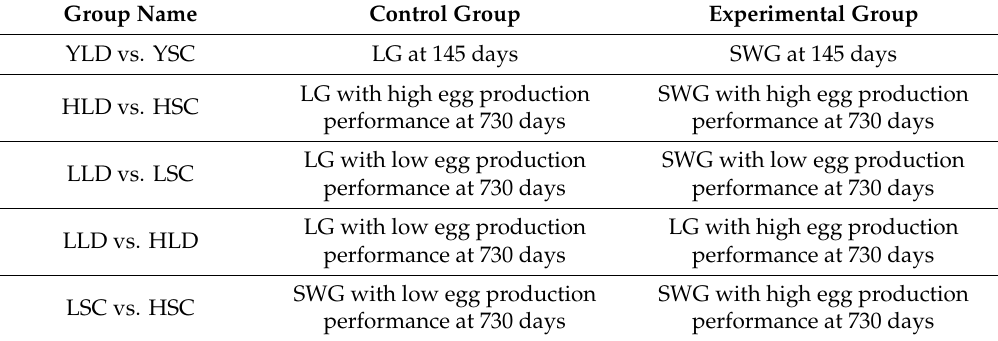
Table 1. Sample grouping information in this